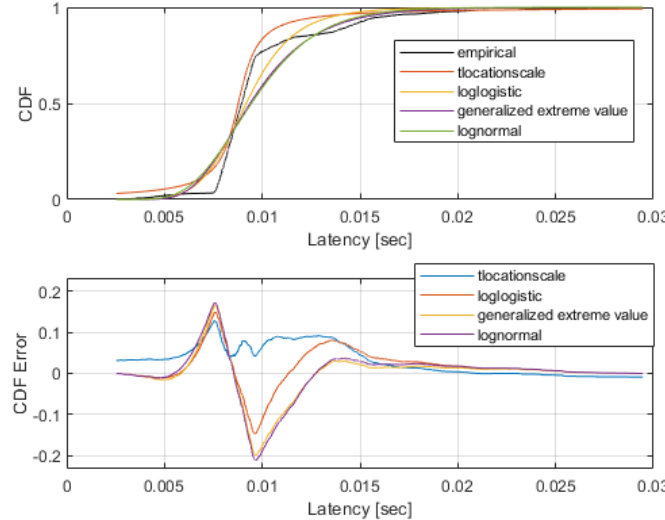
Figure 9. CDF and CDF error of the latency for empirical data and fitting distributions. 5G link only.